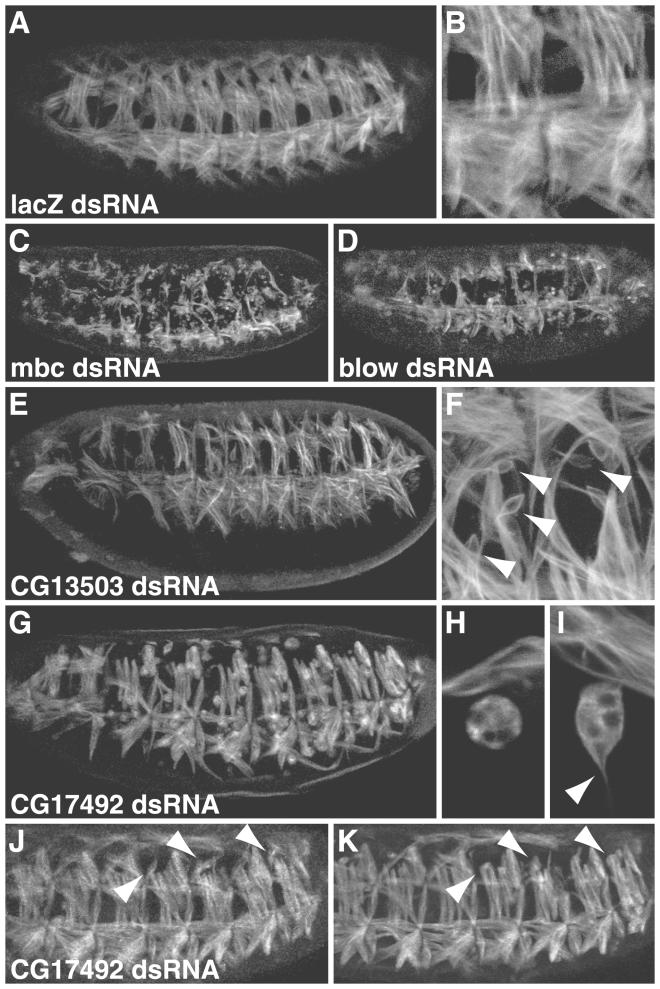
RNAi Analysis of Selected Myoblast Genes(A and B) Live embryos expressing a tau-GFP fusion protein under control of the myosin heavy chain promoter and injected with an inactive control double-stranded lacZ RNA have a wild-type mature muscle pattern. Note, at high magnification (B), the complete absence of unfused myoblasts at this stage.(C and D) Injection of dsRNA for the known muscle fusion genes mbc (C) and blow (D) phenocopy mutations in these genes.(E and F) RNAi directed against the FCM gene CG13503 causes an overall reduction and disorganization of muscle fibers (E), with persistence of unfused myoblasts (arrowheads in F), consistent with a fusion defect.(G–K) Injection of dsRNA for the FC gene CG17492 results in the formation of multinucleate myospheres from only certain muscle fibers. A severely affected embryo (G) demonstrates the complete sparing of certain muscle groups, while other muscles appear as spheres (H) or as compact masses with thin extensions (arrowhead, I). While some abnormalities are apparent before any muscle contraction is visible (J), the same embryo observed later (K) shows that some muscles that had appeared morphologically normal have now formed myospheres (compare arrowheads in J and K).